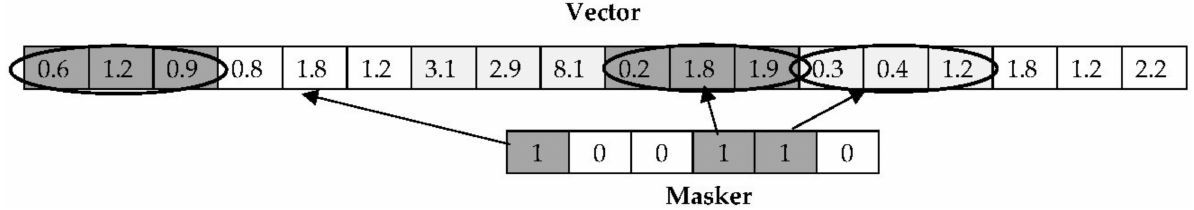
Figure 1. Example of an initial cluster prototype candidate vector and associated